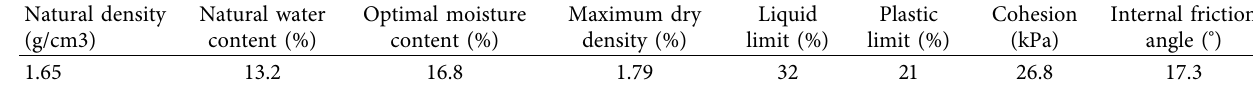
Table 1: Basic physical and mechanical